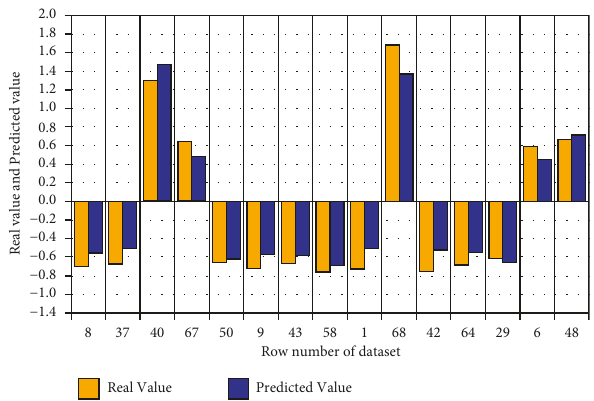
Figure 22: Comparison between real values and predicted values of Boro yield for XGBoost.